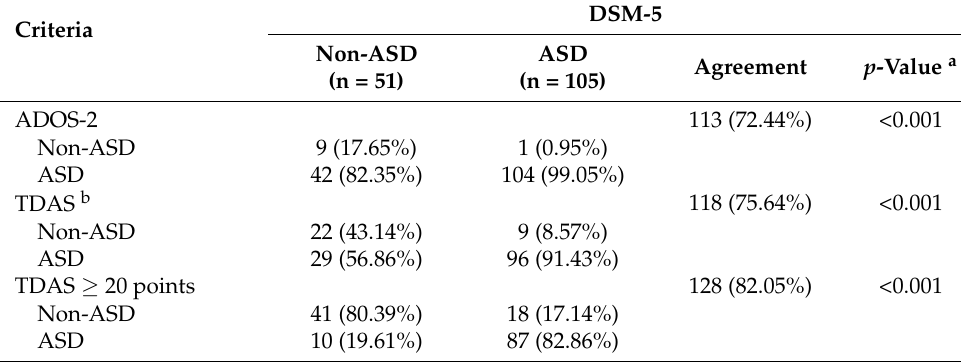
Table 4. ASD diagnosis comparison according to the DSM-5 ASD criteria.